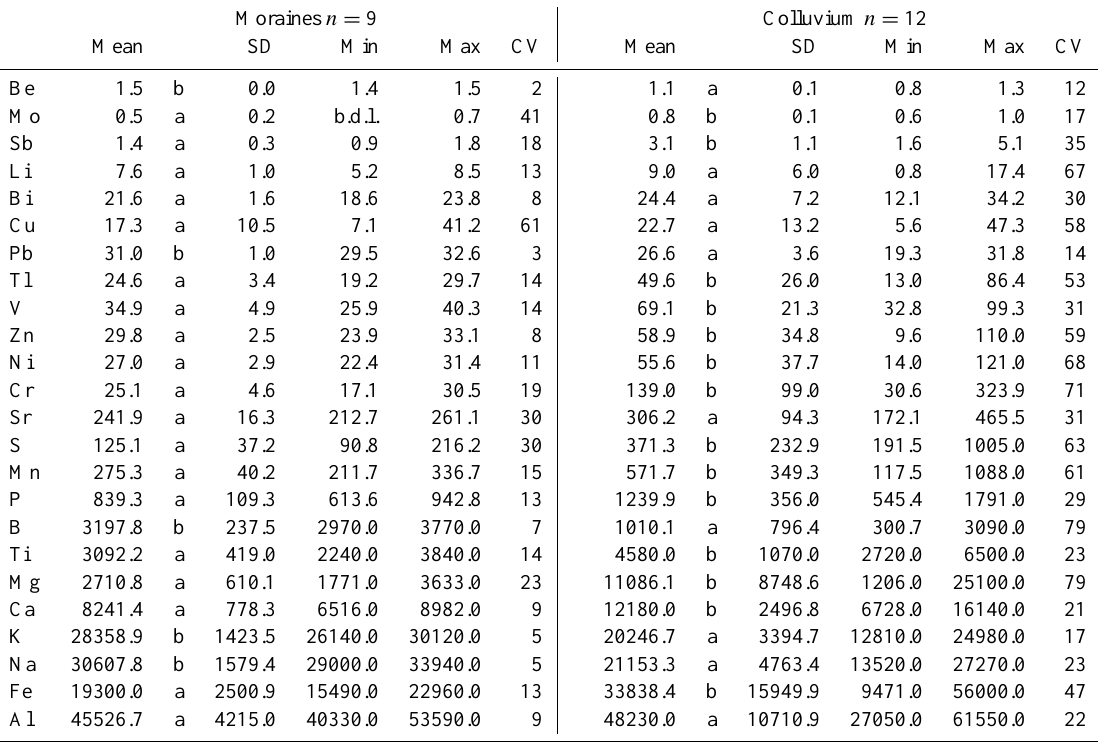
Table 3. Summary statistics of the elemental composition (mgkg − 1 ) in the samples of the soil profiles of the moraines and colluviums. Different letters indicate significant differences at the p level 0.05 between moraines and colluvium soils.